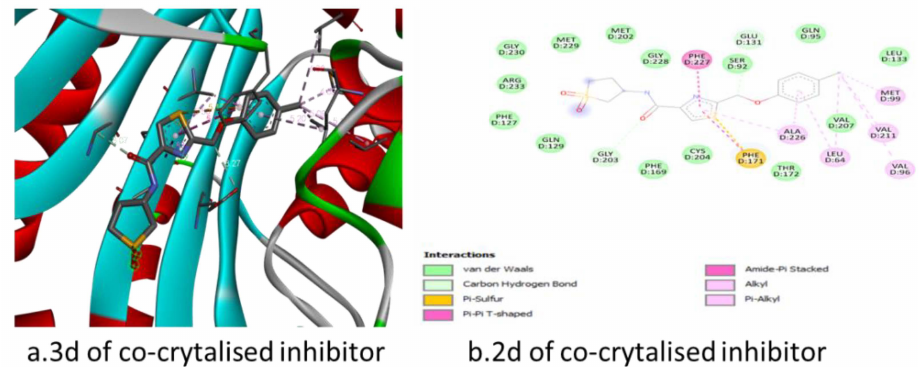
Figure 6. Interaction of the docked co-crystallized substrate with PheRS.